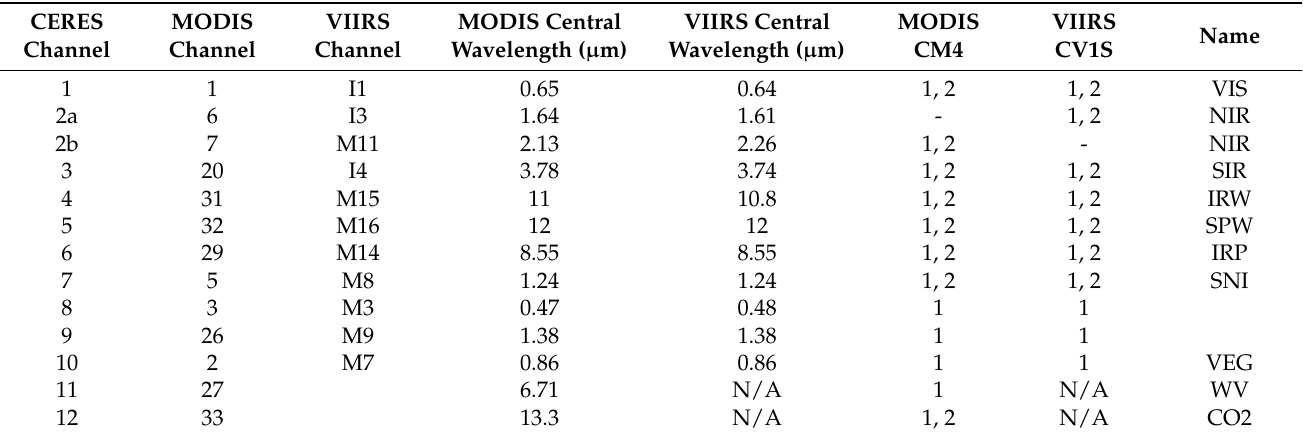
Table 1. Spectral Channels Used in CERES Cloud